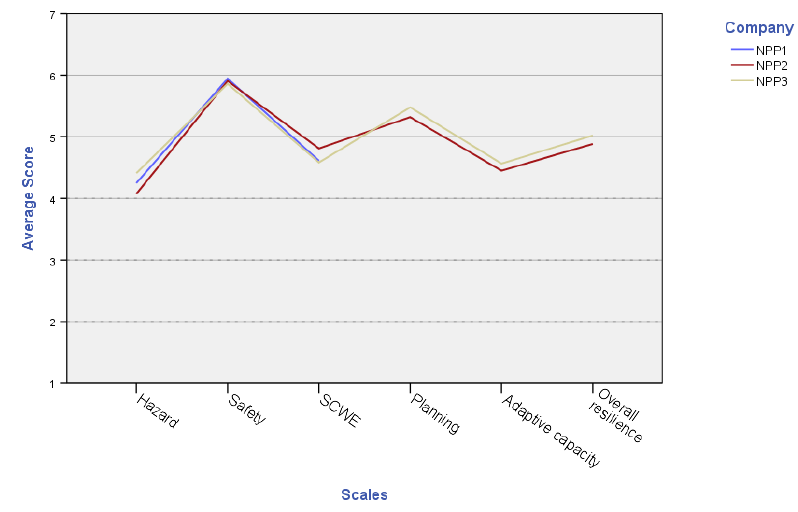
Figure 4. Scale averages by company. The comparison between BARS attention to safety in the nuclear power plants pro- vides quite a compact vision, as shown by Cohen δ values (F(2476) = 0.835, p = 0.434; δ < 0.20) (Table 7, Figure 5). However, it is worth noting that although the three nuclear organizations have a favorable vision of how the organization prioritizes safety, over 12% of personnel in NPP1 and NPP2 think there is a fragile balance between plant safety and production. The most negative visions on this topic (1.71%) are found in NPP 2 (Figure 6). Table 7. Descriptive statistics of the BARS by